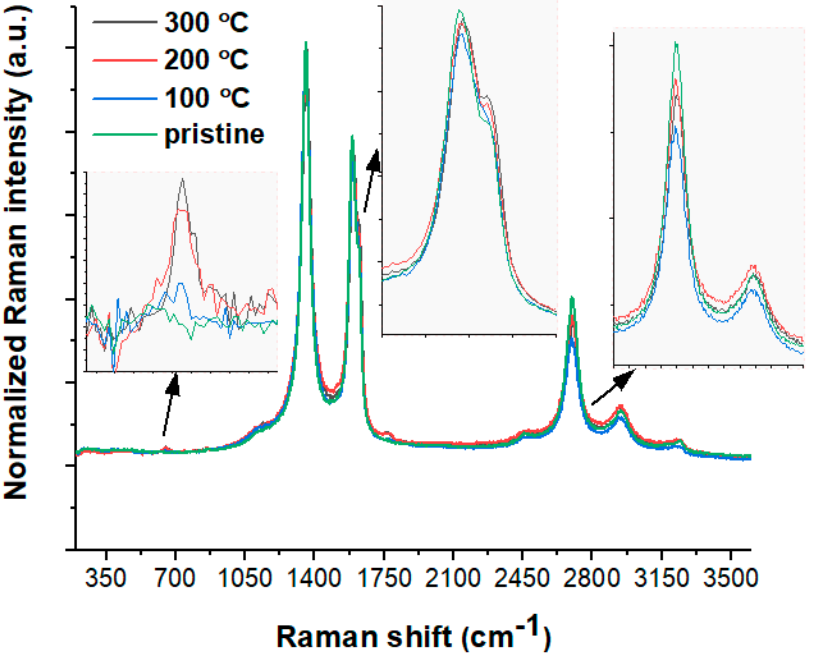
Figure 3. Raman spectra of pristine and calcined f-MWCNTs presented in the 200–3600 cm -1 range. The Raman spectra of the studied CNTs also revealed the D* band at about ~2690 cm − 1 , which is the second harmonic of the D band (see Table 1) [47,53]. According to the literature, the intensity of the D* band corresponds to the extent of impurities in the sample [49] or results from the mass fraction, i.e., the decrease in D* intensity translates into a decrease in the CNT mass [53]. A very similar arrangement of Raman bands was found for the heat-treated samples with only slight differences in intensity and band po- sitions (see Table 1). Furthermore, two interesting observations were made when comparing the heat- treated samples with the pristine material. First, a tiny Raman band around 700 cm –1 ap- peared on the CNTs sintered at 200 °C and 300 °C, suggesting a surface evolution of the carbon nanotubes or, alternatively, point to the precipitation of some impurities or metals. Secondly, the decrease in the D* value as a function of the annealing temperature of the nanotubes may suggest a decrease in the CNT mass fraction (Table 1). The data mentioned before can be used to probe the quality of carbon materials. Here, the ratio between the intensities of the D and G bands or D and D* is generally useful for the characterization of carbon materials [54]. The changes in the I D /I G and I D /I D * ratios for each sample are given in Table 1. Generally, the low value of I D /I G ≈ 0.23 suggests a good quality of the carbon material. In the case of the pristine nanotube, the I D /I G ratio is higher than 1.50, indicating a higher amount of amorphous carbon. What is more interesting is that the I D /I G values for the heat-treated samples are generally close to each other but are much higher than the value for the pristine material. Such behaviour could suggest the local increase in dis- ordered amorphous carbon. The Raman study also allows the purity of the carbon mate- rials to be checked by calculating the I D /I D * ratios. The higher the I D /I D * value, the purer the material studied. Our studies showed very high I D /I D * values for all samples, suggest- ing relatively low carbon impurities, such as aliphatic moieties or methyl groups.